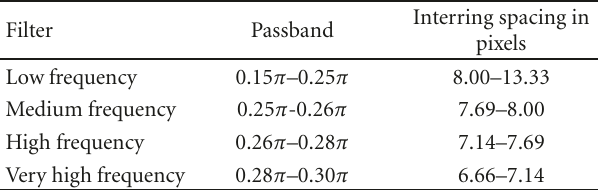
Table 1: Variable frequency spacing filterbank specifications. The vertical filter parameters for the four filters in the filterbank for the 20 populus images are given in the table. Here, the training set was 5 images and transition bands were set to 0.005. The row filter stopband was set from − 0.65 to 0.45 with 0.2 transition bands. All separable filters used 45 coe ffi